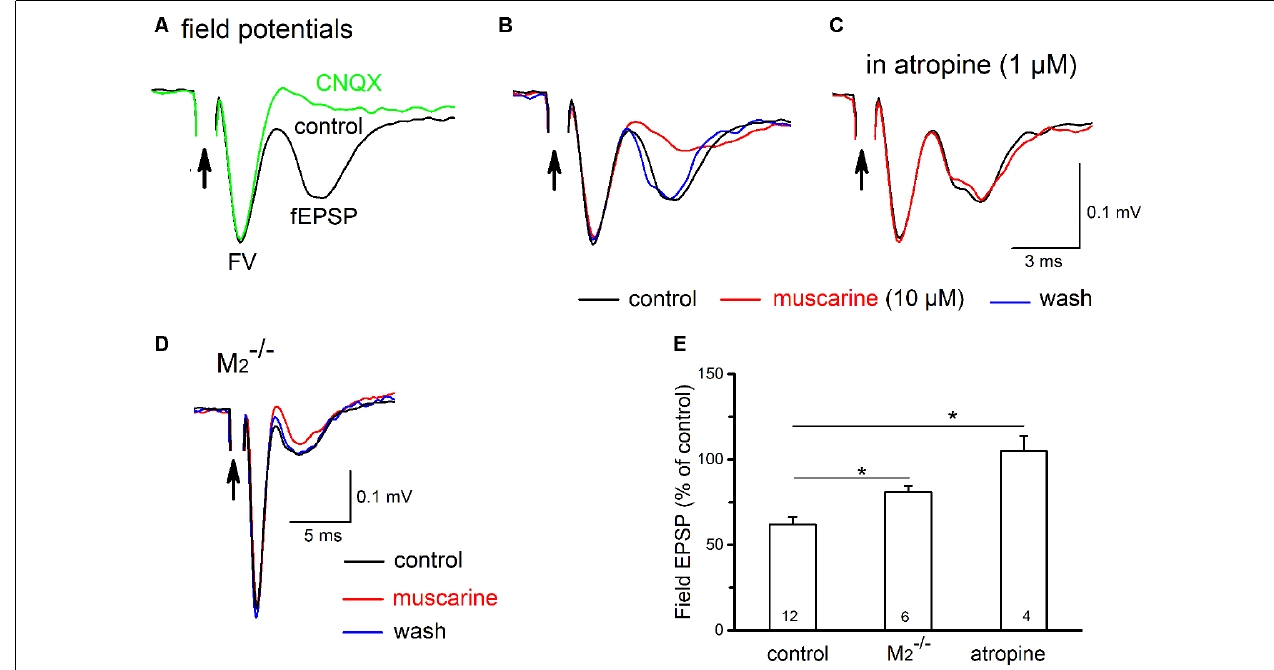
FIGURE 11 | Muscarine reduces field excitatory postsynaptic potentials (fEPSPs) in the preBötC. (A) Electrical stimulation (100 µ s, 100 µ A; indicated by arrow) of the adjacent reticular formation evoked fEPSPs in the preBötC, consisting of an early axonal component (fiber volley, FV) and a late synaptic component (fEPSP). All recordings were performed in the presence of picrotoxin and strychnine to block fast inhibitory synaptic inputs. The late component was sensitive to AMPA receptor blockade by CNQX (20 µ M) as indicated by comparing the two superimposed traces. (B) Muscarine (10 µ M) produced a reversible attenuation of the fEPSP (traces in control, muscarine and during wash superimposed). In the same recording session, we repeated muscarine application in the presence of atropine (1 µ M) and under these conditions muscarine failed to affect fEPSP amplitude (C) . (D) Superimposed traces recorded from the preBötC of an M 2 − / − mouse illustrate attenuation of muscarine fEPSPs suppression. Arrows in (A–D) indicate truncated stimulating artifacts. Each trace is an average of 6–10 consecutive recordings. (E) Histogram summarizes muscarine-induced changes in peak fEPSP amplitude, expressed as a percentage of control values. The partial involvement of M 2 R is indicated by the reduced muscarinic effect in M 2 − / − mice which were intermediate between atropine (no effect) and control. Numbers in columns represent sample number in each group ( ∗ p <